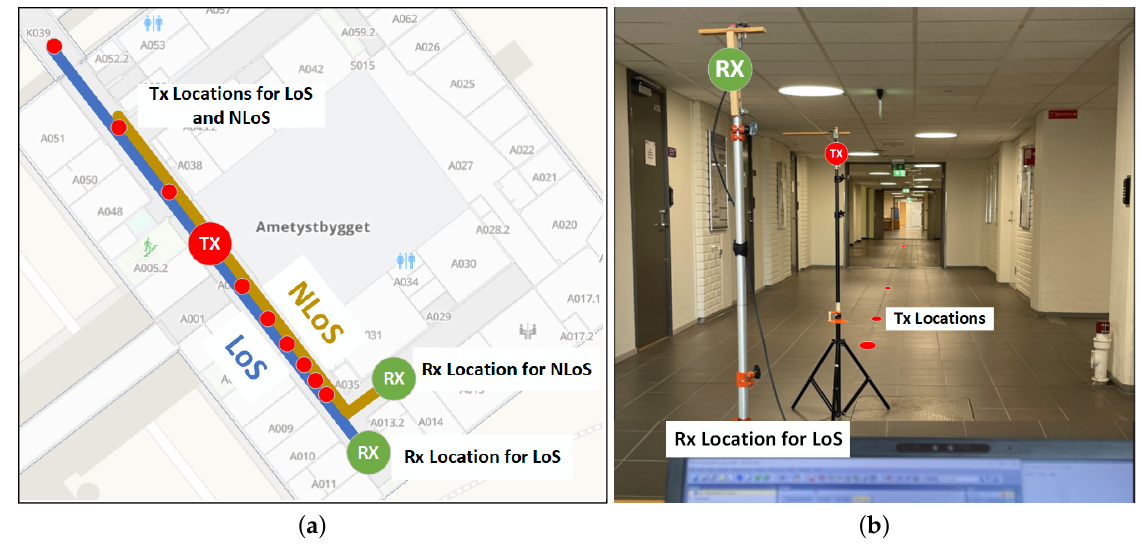
Figure 1. Experimental indoor location, Ametystbygget NTNU, Gjøvik. ( a ) Top view of the building in which the measurements were conducted. ( b ) The corridor where the experiment is performed.